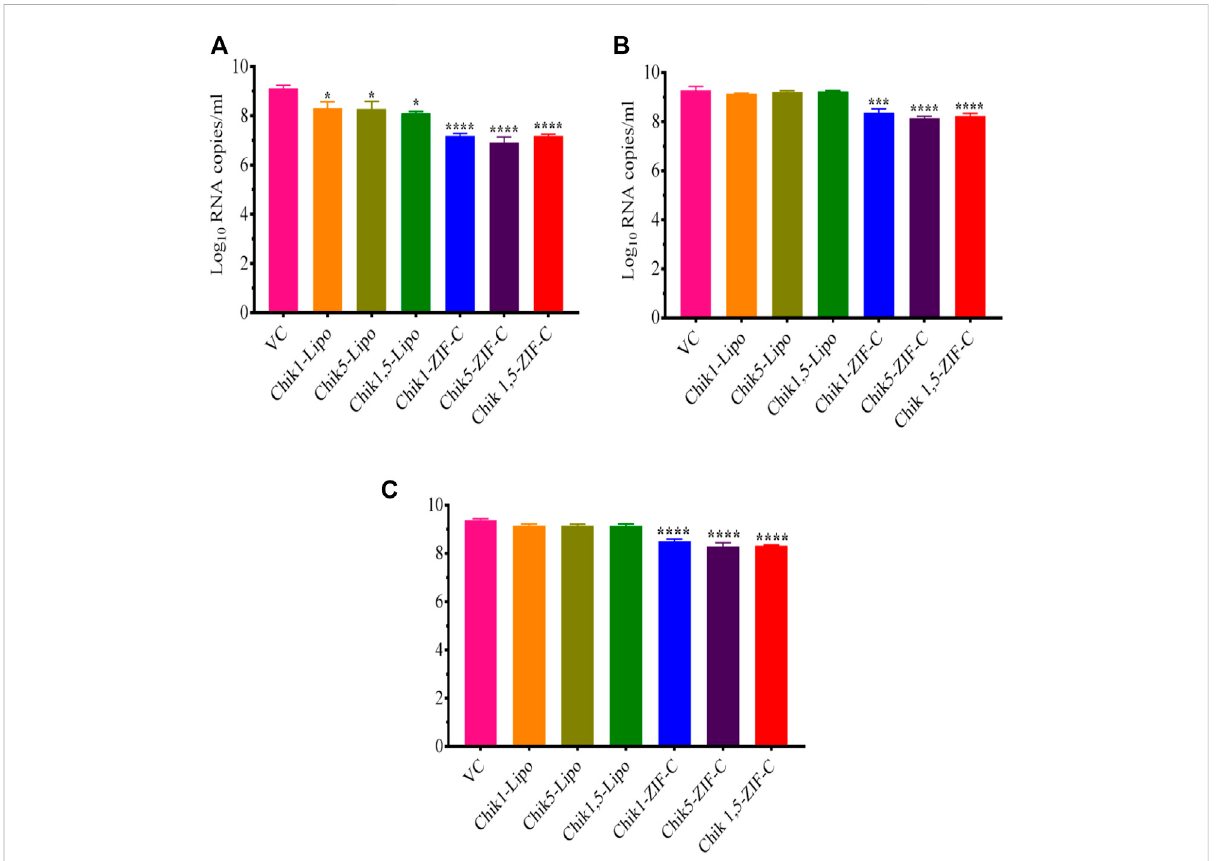
FIGURE 5 Inhibitory Effect of siRNA-ZIF-C formulations and lipofectamine based siRNA transfection on CHIKV RNA levels quanti fi ed by qRT-PCR at treatment after 0 h. p.i, (A) 3 h. p.i and (B) 6 h. p.i (C) . For qRT-PCR, total RNA was extracted and the CHIKV RNA copy number was measured using real-time RT-PCR. The experiments were performed in triplicates in three independent trials. All the values are expressed as mean ± SEM of three experiments. The viral RNA copy number was compared between VC and different siRNA formulations using one-way ANOVA with multiple corrections (**** p < 0.0001; *** p <